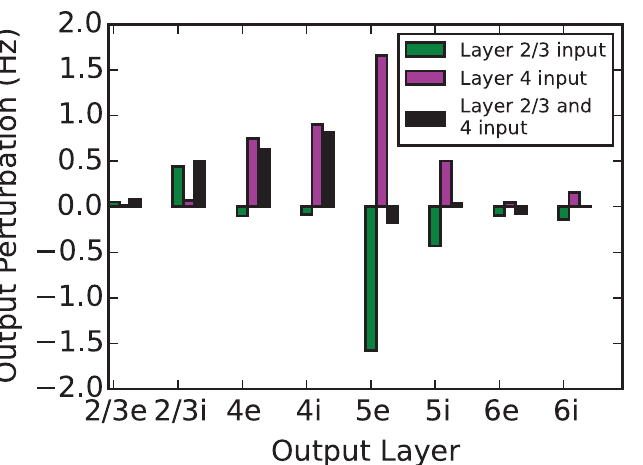
Fig 4. Perturbations resulting from balanced target specificity (equal excitatory and inhibitory input), L2/3, L4, and both together. The eventual change in steady-state of each subpopulation in the model differs in response to three balanced inputs. We focus on the response of the L5e and L5i subpopulations; the effect of inputs into L2/3, as compared to L4, are opposite and nearly equal. When both inputs are simultaneously applied, they approximately offset each other in their combined effect on the perturbation in L5. This indicates that L5 activity is representing the difference between the L4 and the L2/3